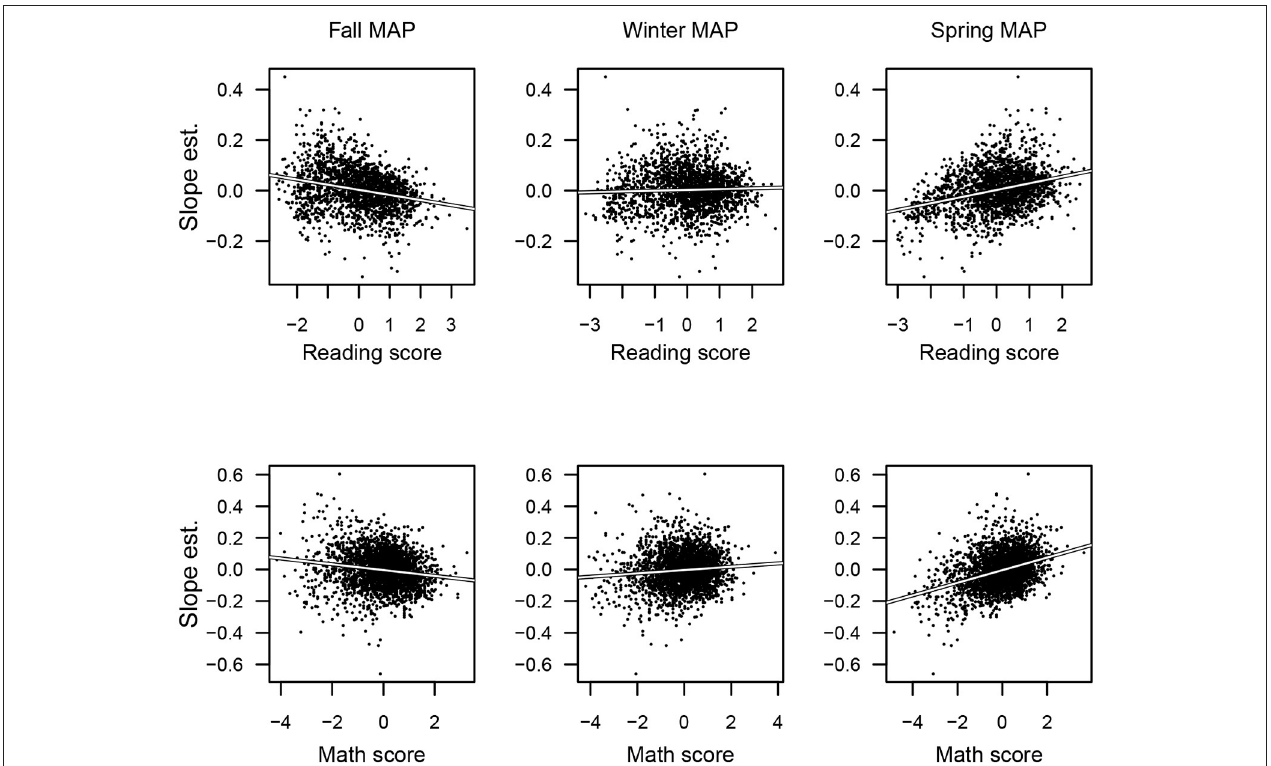
FIGURE 2 | Plots between the slope estimates from the multilevel models with the Fall, Winter, and Spring administrations of the Reading (top) and Math (bottom) MAPs administrations. The downward slope on the left-side panels and the upward slopes on the right-side panels are consistent with regression to the mean. The slight positive slope for the middle column for math shows a tendency for those with high scores to improve more than those with low scores. Three thousand points (jittered) are shown in the scatter plots.